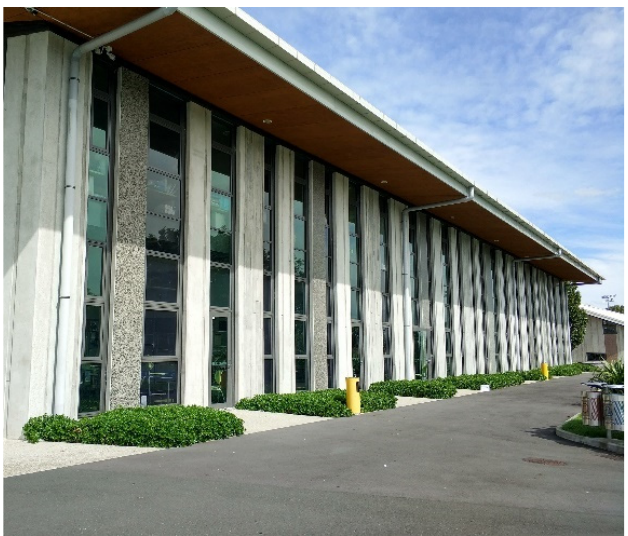
Figure 3. New school building with precast insulated concrete panel